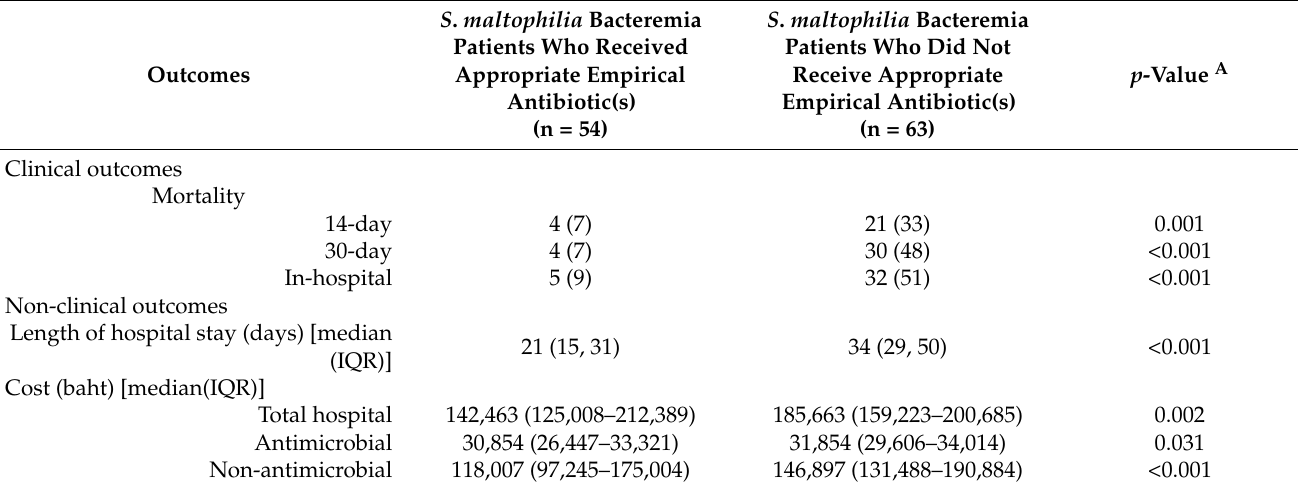
Table 3. Comparison of outcomes between patients with S. maltophilia bacteremia who did or did not receive appropriate empirical antibiotic(s).